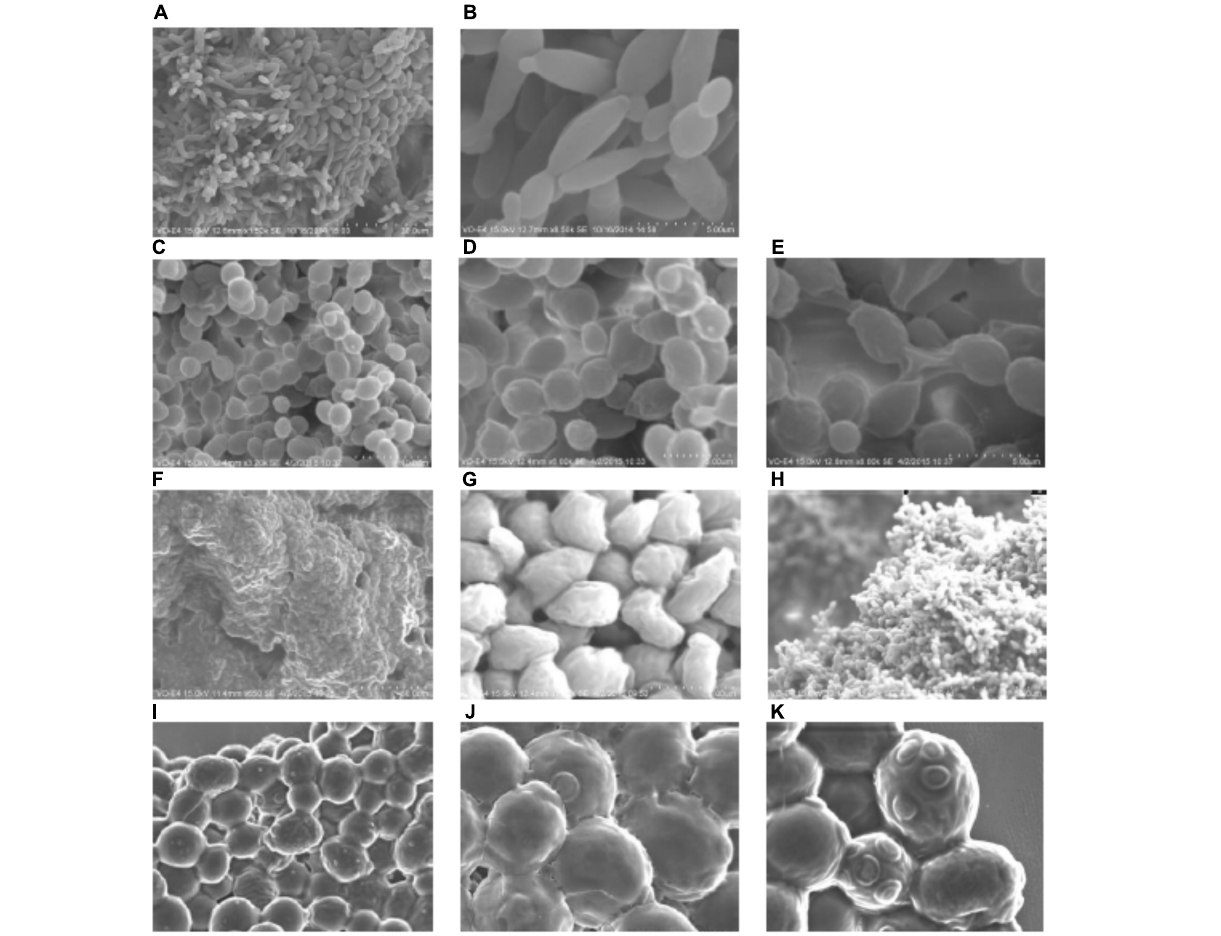
Frontiers in Microbiology |